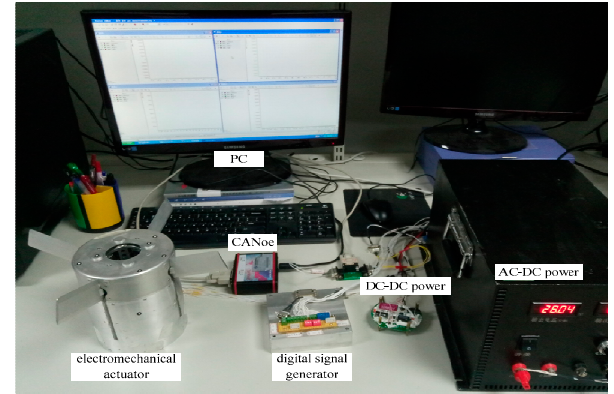
Figure 6. The experimental setup of EMA system.